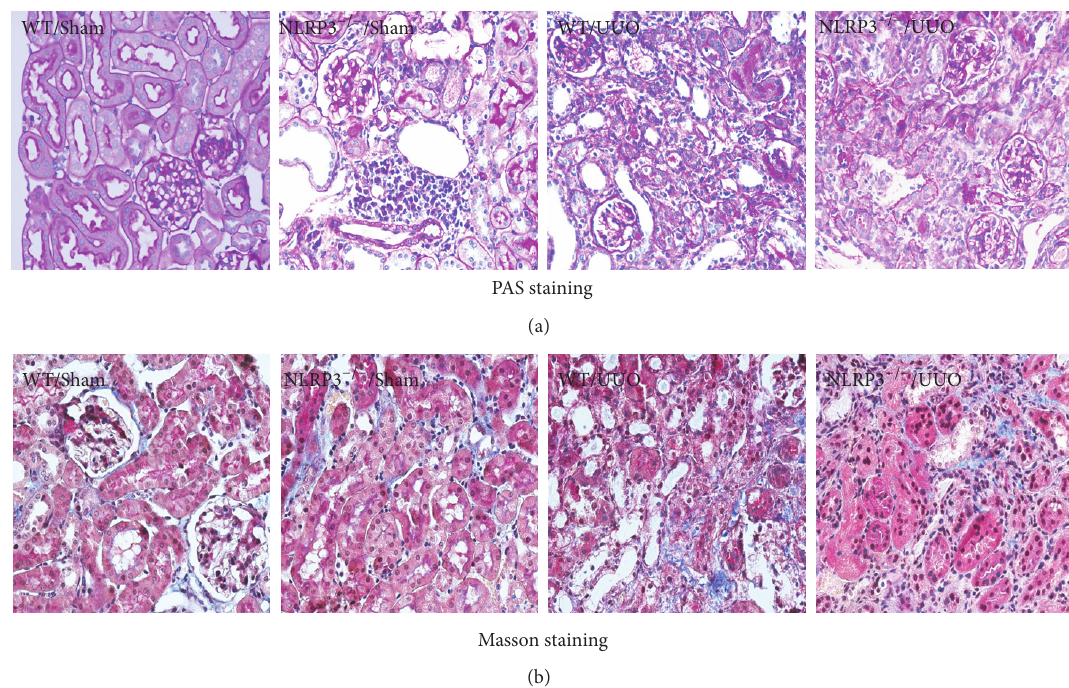
Figure 1: Demonstration of kidney histopathology at day 14 UUO. Representative photomicrographs of periodic acid-Schiff-stained kidney sections ((a), magnification, × 400) and Masson trichrome-stained kidney sections ((b), magnification, × 400).